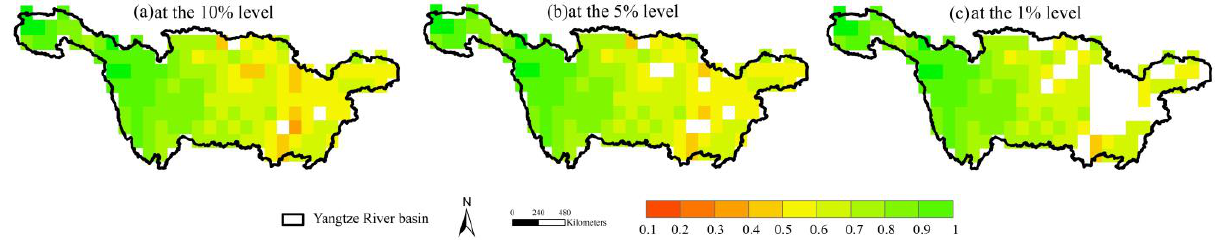
Figure 6. Mean correlation coefficient between multiple GRAFO-derived (i.e., 80 data sets) and GLDAS-modeled (i.e., 3 hydrological models) runoff data in the Yangtze River basin between July 2018 and October 2020, on which a grid cell is plotted only if the respective test is locally significant at the ( a ) 1%, ( b ) 5%, and ( c ) 10% significance lever.